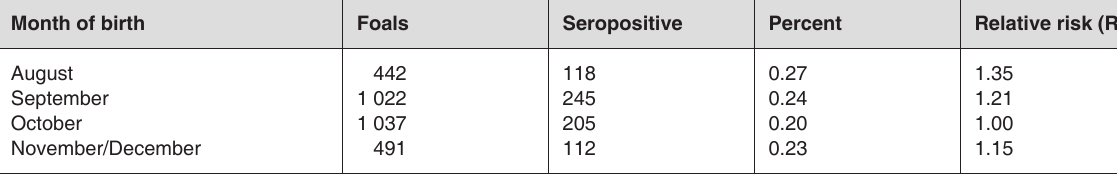
TABLE 2 Influence of age on susceptibility to natural EEV challenge Month of birth